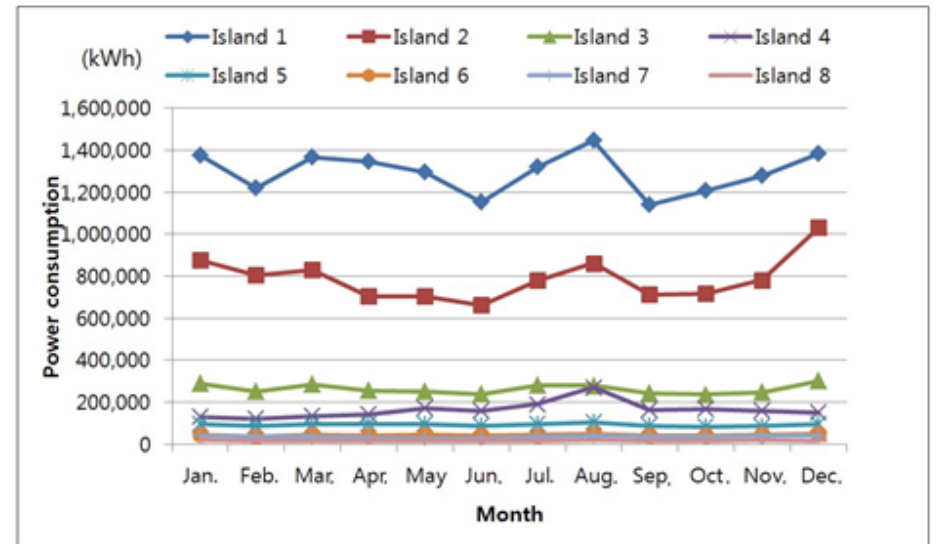
Figure 3. Power consumption with months for 1 year.